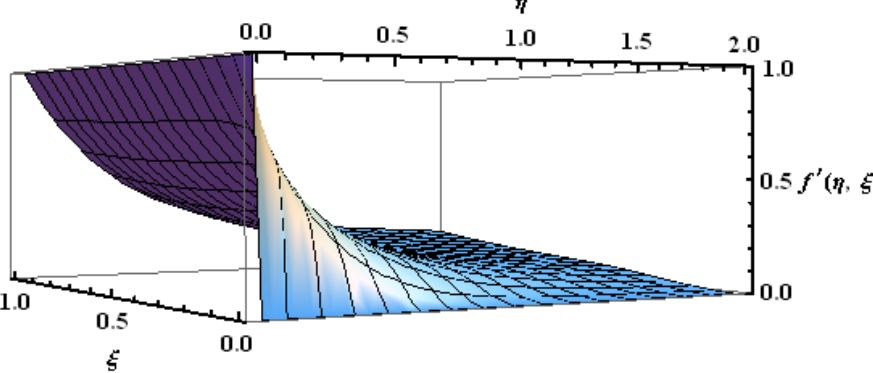
Figure 2. Surface of f (cid:48) ( ξ , η ) for ξ ∈ [ 0,1 ] and for η ∈ [ 0, ∞ ] .